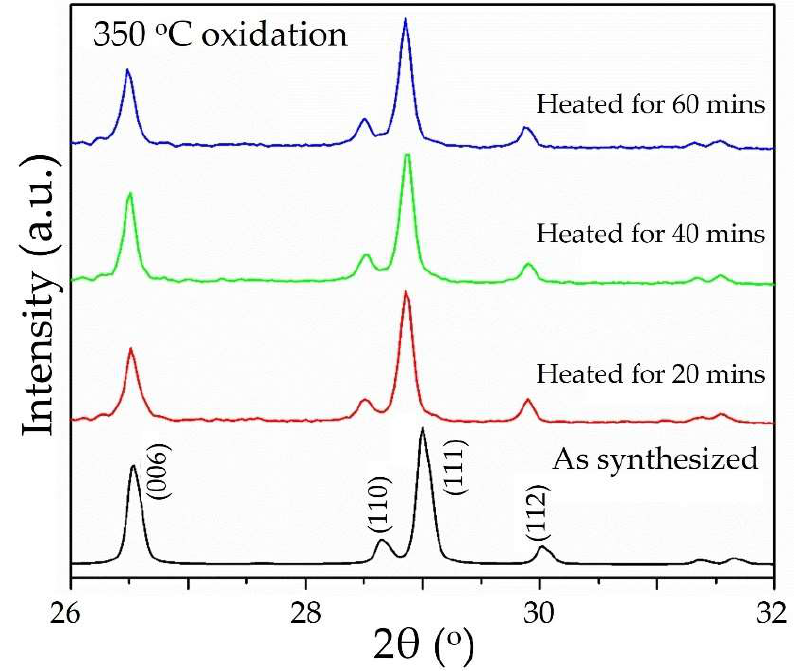
Figure 3. Powder XRD data, illustrating the peak shiting after heating Cu 3 Ta 7 O 19 in air to 350 °C for 20 min, 40 min, and 60 min.